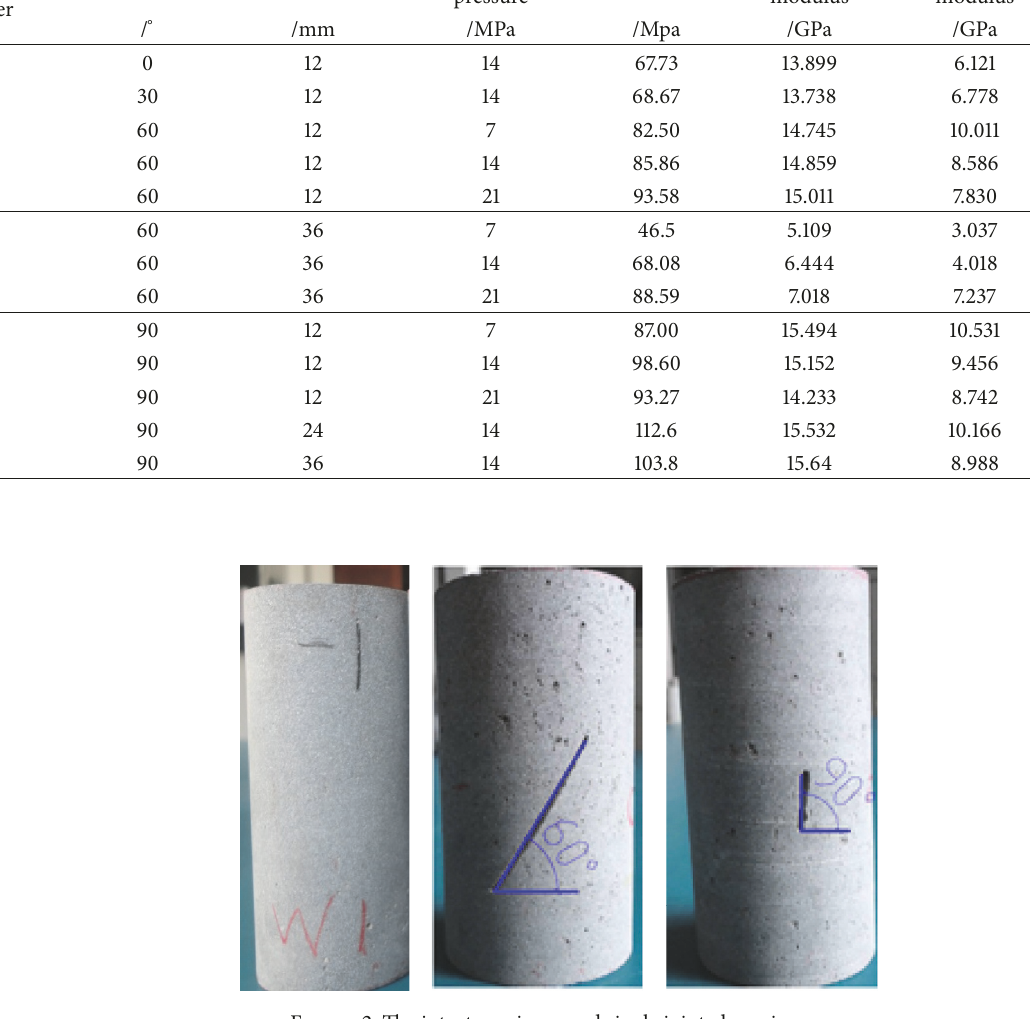
Table 3: Results of the triaxial compression tests about these single jointed specimens. Specimen